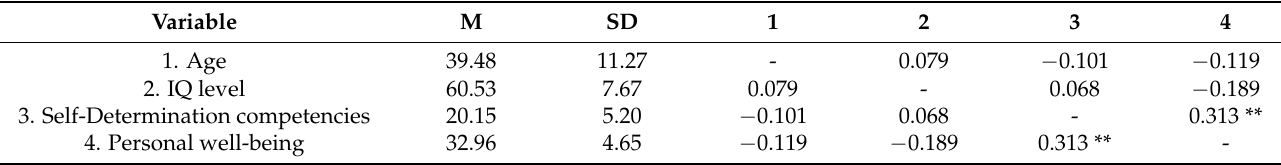
Table 3. Means, Standard Deviations, and Correlations of Self-Determination Competencies, Demographic Variables, and Personal